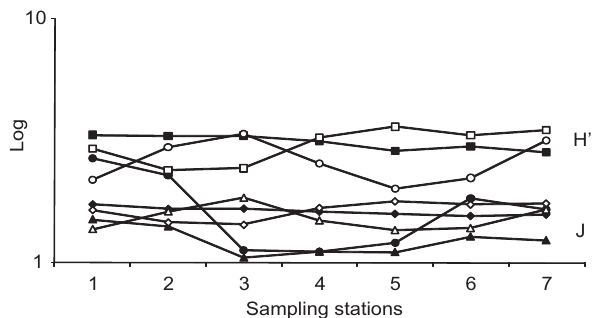
Figure 9. Diversity index (H’) and evenness (J) at sampling stations on the inner shelf adjacent to Camamu Bay during the 2-year sam- pling period (black – 2003 and open – 2004): circle – H’ (Rainy season), square – H’ (Dry season), triangle – J (Rainy season), dia- mond – J (Dry